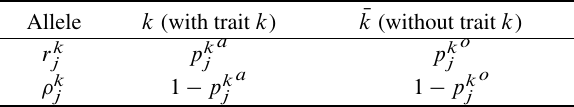
Table 1 Probability of risk allele r k and non-risk allele (cid:26)(cid:26)(cid:26) k j the SNP j ’ position conditioned on one of the associated trait k o and p k a represent the risk allele frequency of SNP j . Here p k j j in control and case group, respectively.